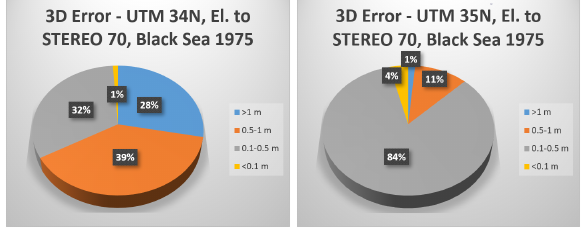
Figure 8 . Transformation statistics for 3D